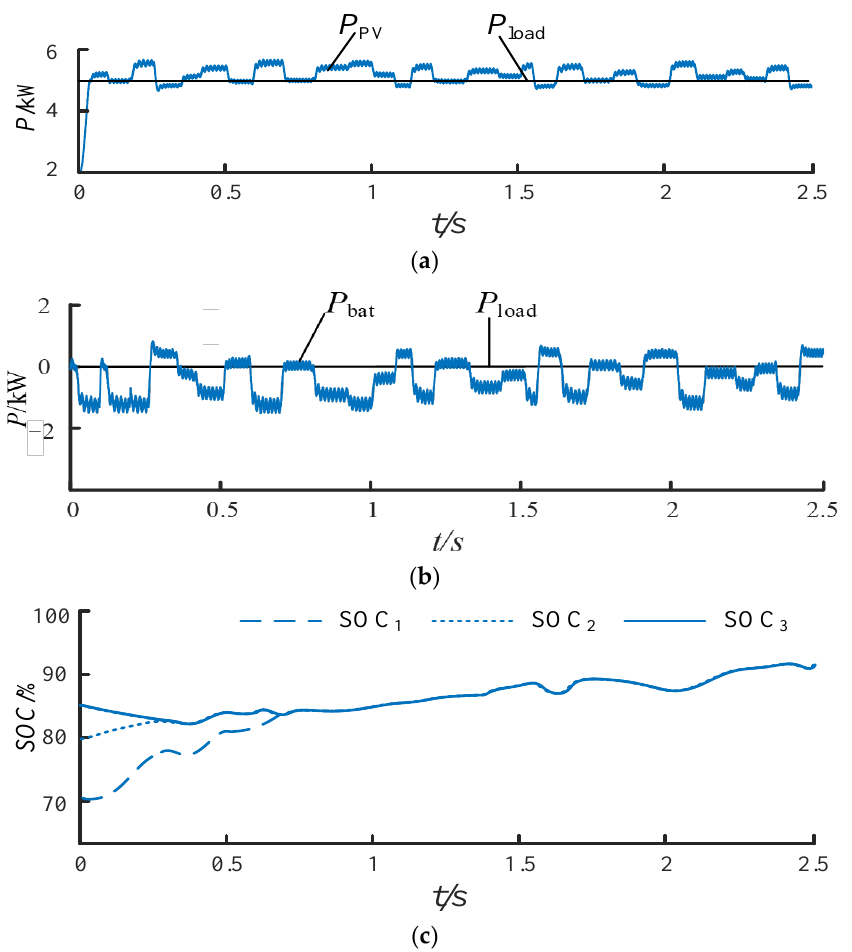
Figure 12. Dynamic response capability of the energy storage system. ( a ) Photovoltaic and load unit power. ( b ) DESS and load unit power. ( c ) ESU SOC curve.